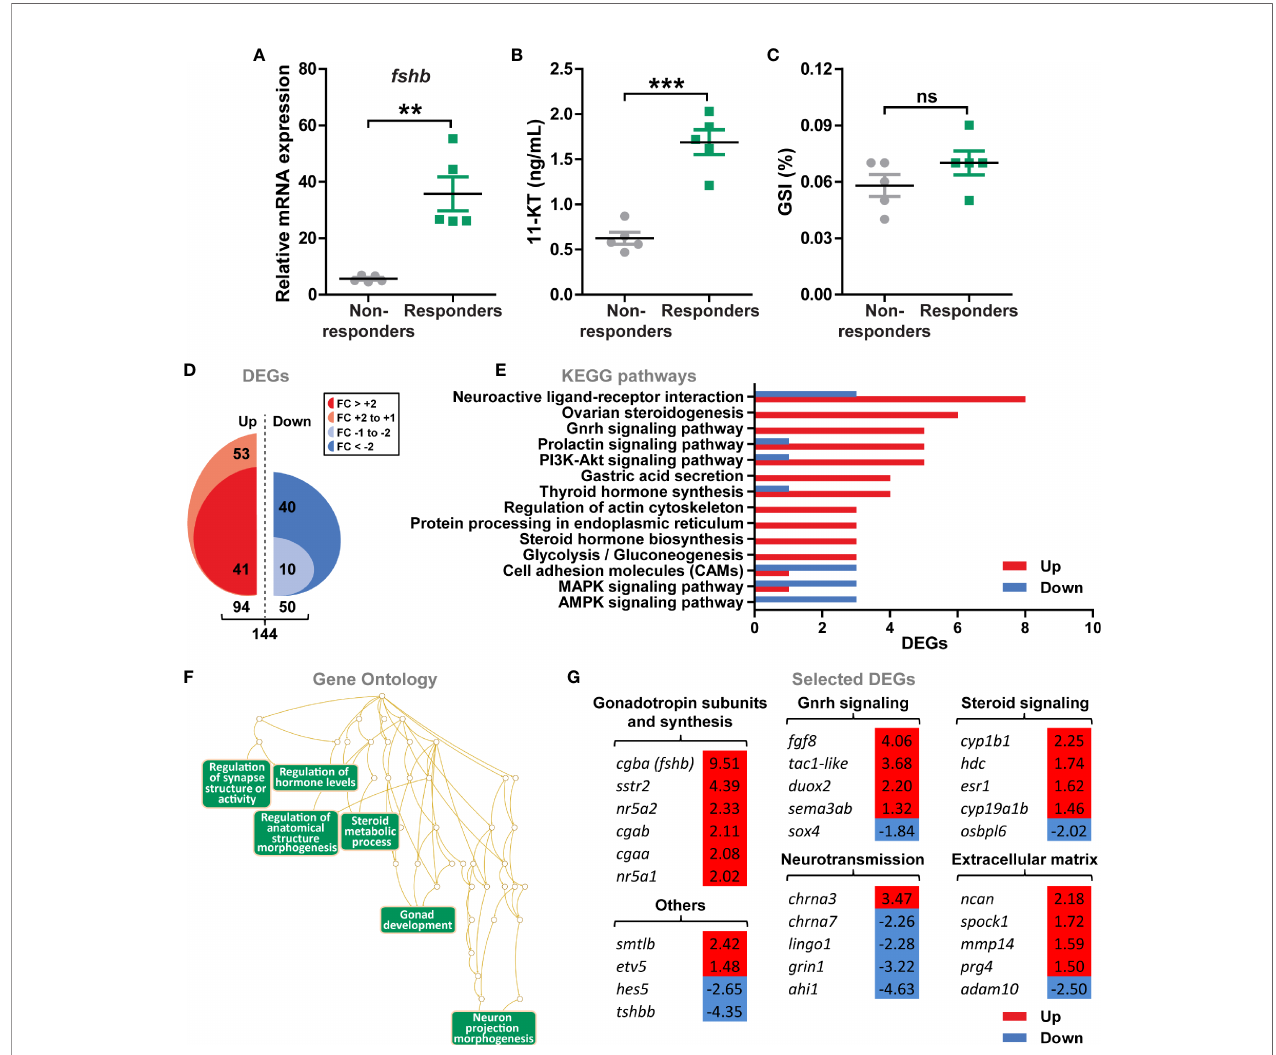
FIGURE 4 | Gene expression pro fi ling of pituitaries from male postsmolts about to enter puberty. (A – C) To select pituitary samples for RNAseq, sibling salmon males with low genetical variance were sampled at day 7 and 11 after exposure to stimulatory conditions (constant light and 16°C) and different puberty-associated parameters evaluated. Analysis of fshb expression (A) and 11-ketotestosterone [11-KT; (B) ] levels revealed two groups of fi sh showing low (non-responders) or high (responders) levels for both parameters, while gonado-somatic indices (GSI; C) were unaffected. Data are shown as mean ± SEM (N = 5; **p < 0.01; ***p < 0.001). ns, no signi fi cant differences between groups. (D) Total numbers of up- and down-regulated genes (DEGs) identi fi ed by RNAseq (N = 5; p-adjusted < 0.001). (E, F) Regulated KEGG pathways (E) and Gene Ontology (F) terms in pituitaries of males responding to stimulatory conditions. KEGG pathways represented by at least 3 DEGs and ratio of regulated genes higher than 2.5 were considered for the analysis. (G) Selected DEGs identi fi ed by KEGG and GO analyses grouped by their function. Fold change values are shown with a red or blue background indicating up- or down-regulation,